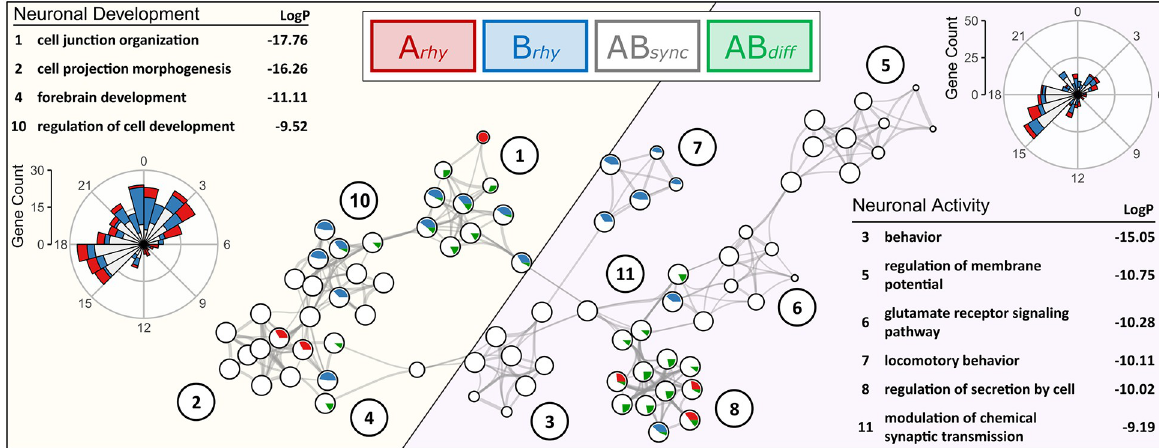
Fig 6. GO Biological Process enrichment network of subsets identified by dryR. Statistically significant enriched GO Biological Process terms were clustered based on similarities among rhythmic genes found within the subsets identified by dryR. The term with the lowest P value within each cluster was chosen as a representative label. Each GO term is represented by a circle node, with size proportional to the number of genes. Color and size of the pie sectors represent the number of hits originated from each respective subset (transcripts rhythmic in Group A— Arhy = red, transcripts rhythmic in Group B— Brhy = blue, transcripts rhythmic in both groups with similar phase— ABsync = white, transcripts rhythmic in both groups with different phase— ABdiff = green). The network represents 10 of the 12 most significant clusters, with blood vessel development (9) and sensory organ development (12) omitted from the figure because they were not connected to other clusters within the network. Two main branches are highlighted: The right branch (purple) is associated with neuronal activity, while the left branch (yellow) is comprised of genes associated with neuronal development. -LogP-values of the enrichment and phase distribution of genes found within the respective branches are shown on the far right (neuronal activity) and left (neuronal development), respectively. For raw data, see S4 Data. GO, Gene Ontology.